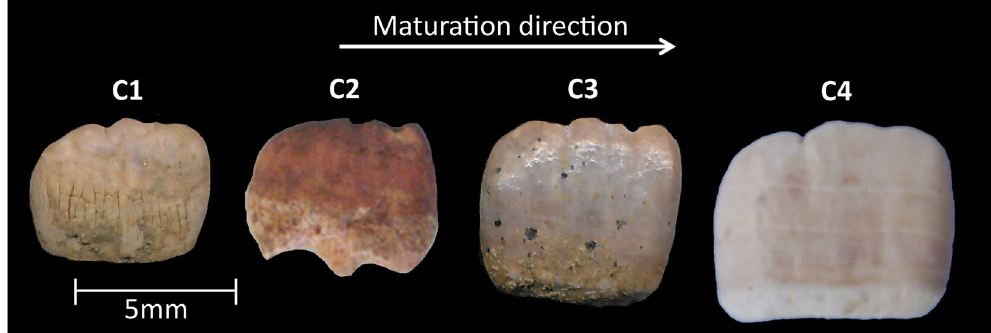
Figure 8. Photographs of the four human permanent maxillary central incisors at various developmental stages obtained from the 12 th –16 th century AD medieval cemetery of Blackfriars (Gloucester,